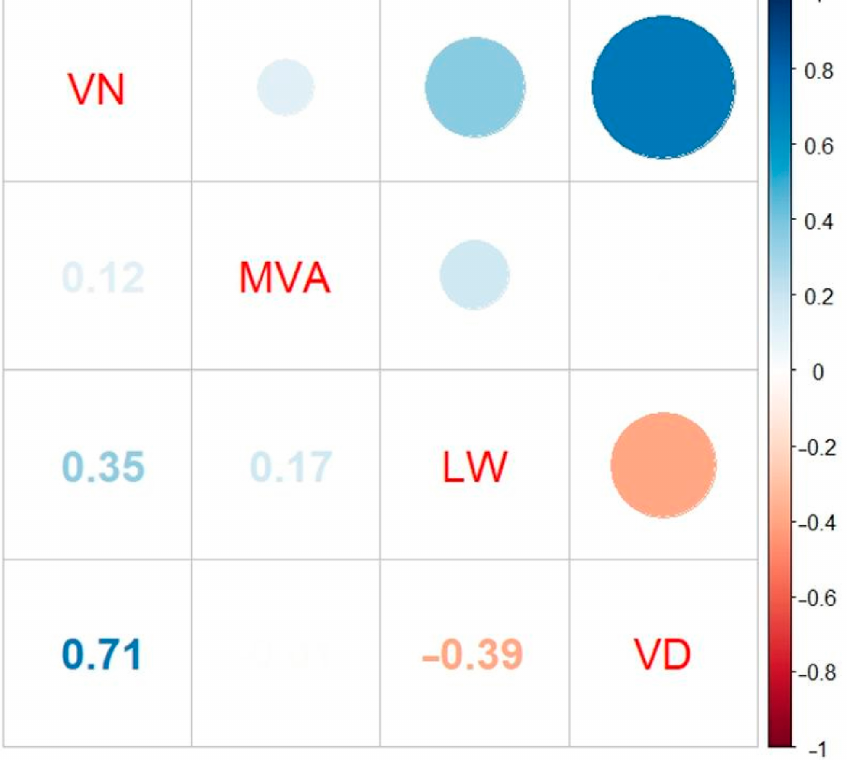
Figure 3. Correlation analysis of leaf veins’ phenotypic traits at ear leaf of maize among 300 in- bred lines. Table 3. Single-factor variance analysis among different subgroups of ear leaf veins’ phenotypic